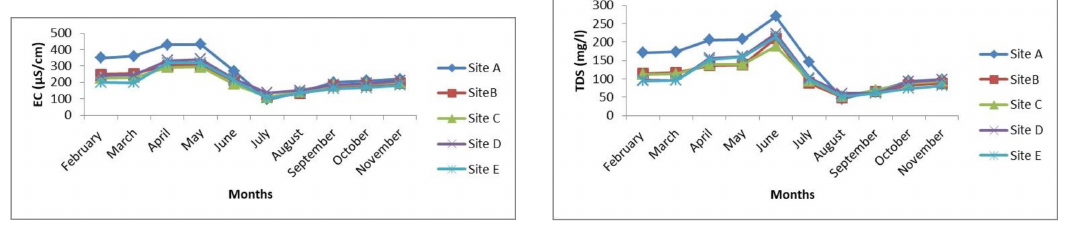
Figure 6. Monthly mean variations in electrical conductivity of Nasarawa Reservoir.